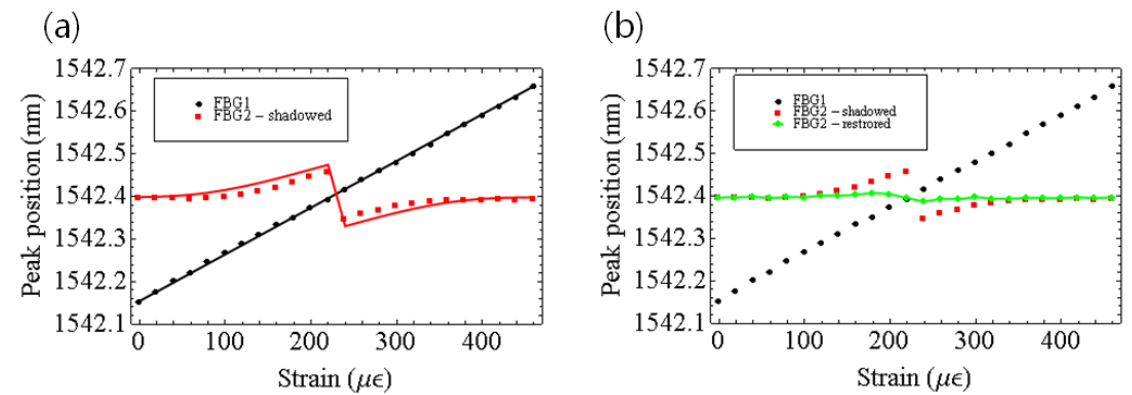
Figure 5. ( a ) The wavelength detection error due to the shadowing effect (dots: experimental data, solid curve: simulation data); ( b ) suppression of the shadowing effect using the restoration